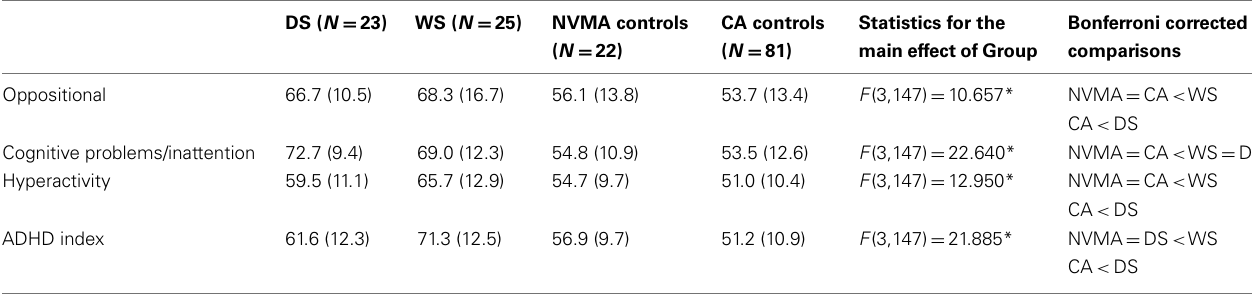
Table 2 | Inattention and hyperactivity across